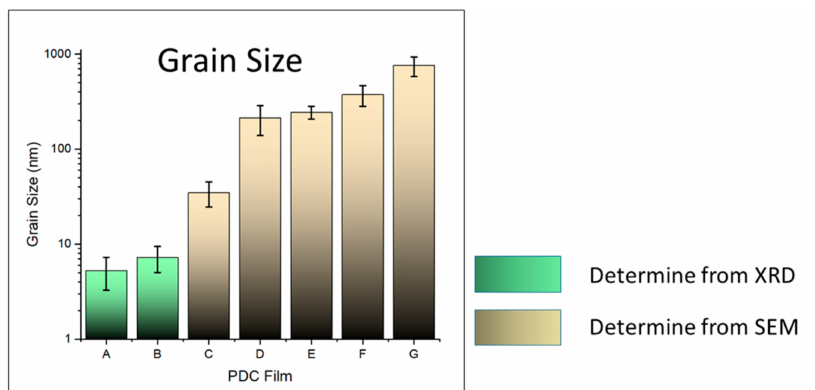
Figure 3. Grain size for PCD films (samples A–G from Table 1). The grain sizes of PCD films A and B were determined using the XRD peaks, while for PCD films C to G the grain sizes were determine using SEM